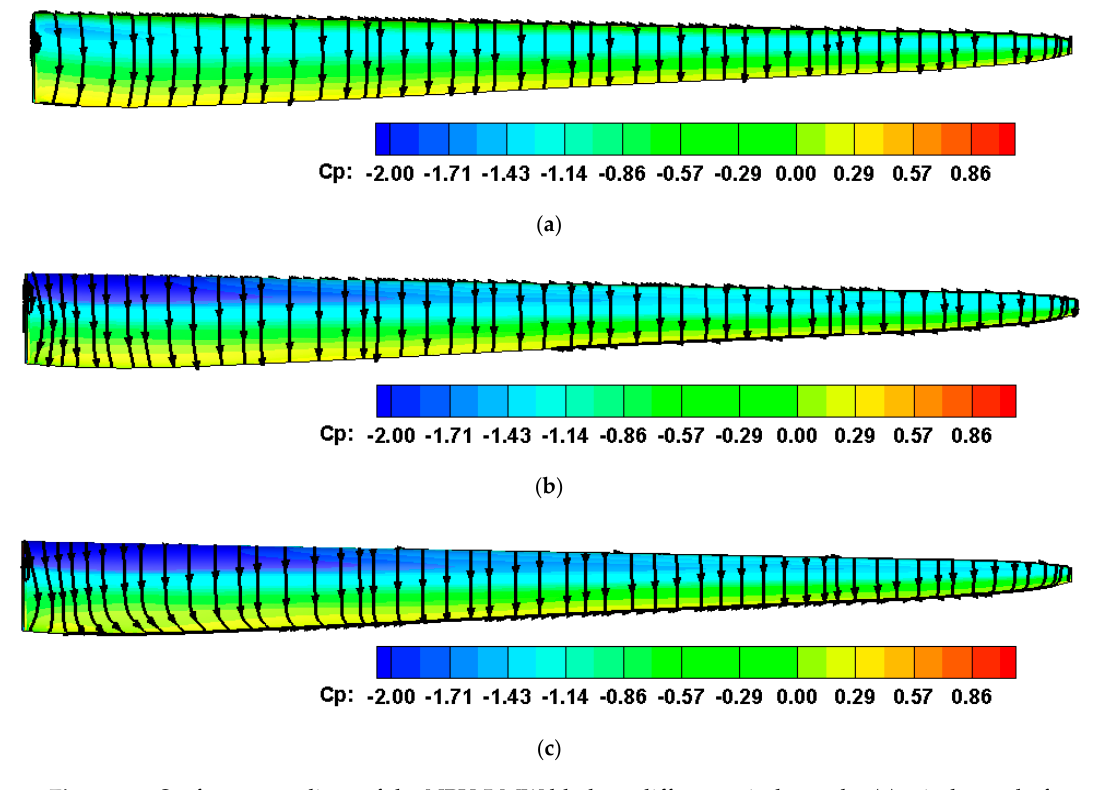
Figure 27. Surface streamlines of the NPU 5 MW blade at different wind speeds: ( a ) wind speed of 3 m/s; ( b ) wind speed of 7 m/s; ( c ) wind speed of 11 m/s.